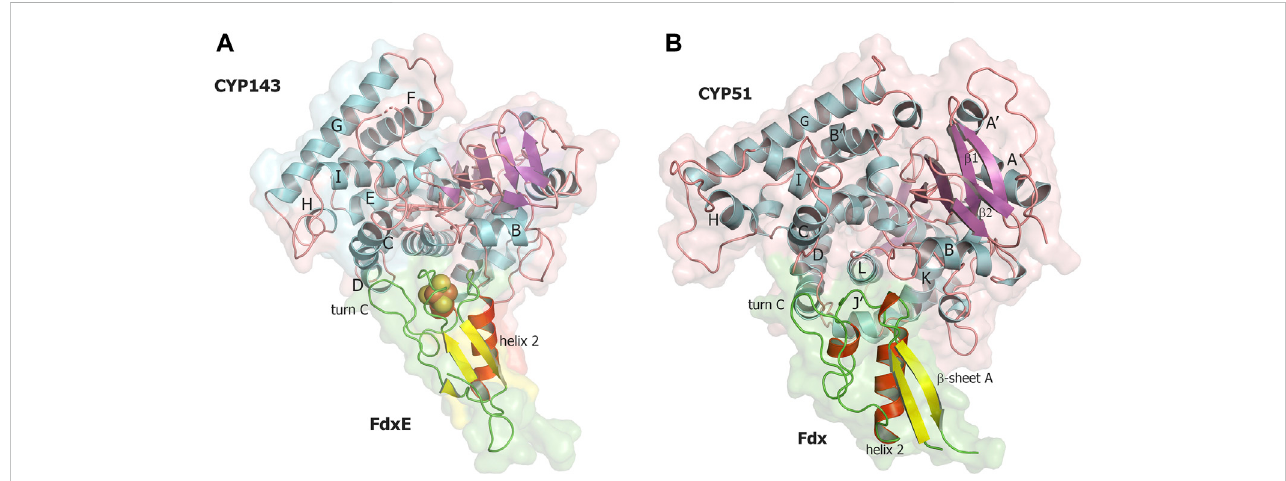
FIGURE 7 Comparison of two complexes of CYP with 3Fe – 4S ferredoxins. (A) FdxE − CYP143 complex obtained in this work, (B) CYP51 ̶ Fdx modeled with AlphaFold2. CYP143, and CYP51 are colored by secondary structures in cyan, magenta, and salmon for the helix, sheet, and loop, respectively; FdxE and Fdx are colored in red, yellow, and green for helix, sheet, and loops,